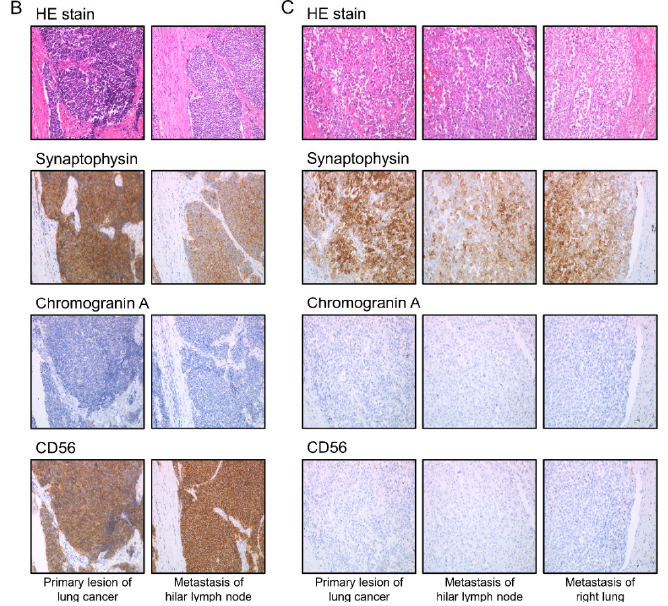
Figure 2. Histopathological findings in the three SCLC patients ( A ) case no. 1, ( B ) case no. 2, and ( C ) case no. 3. Micrographs were taken at 200 × magnification.